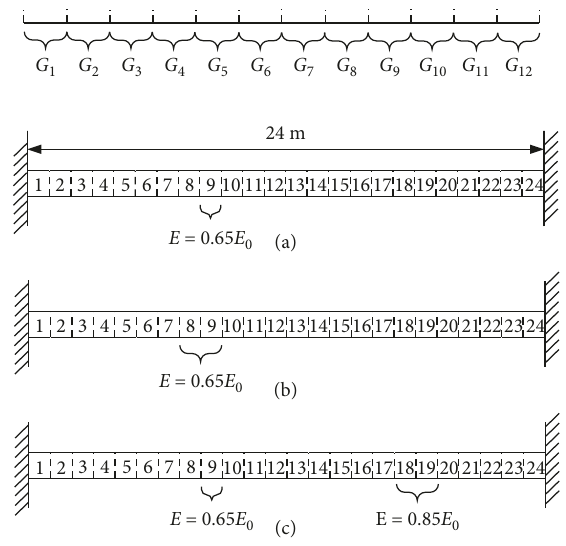
Figure 11: The inappropriate